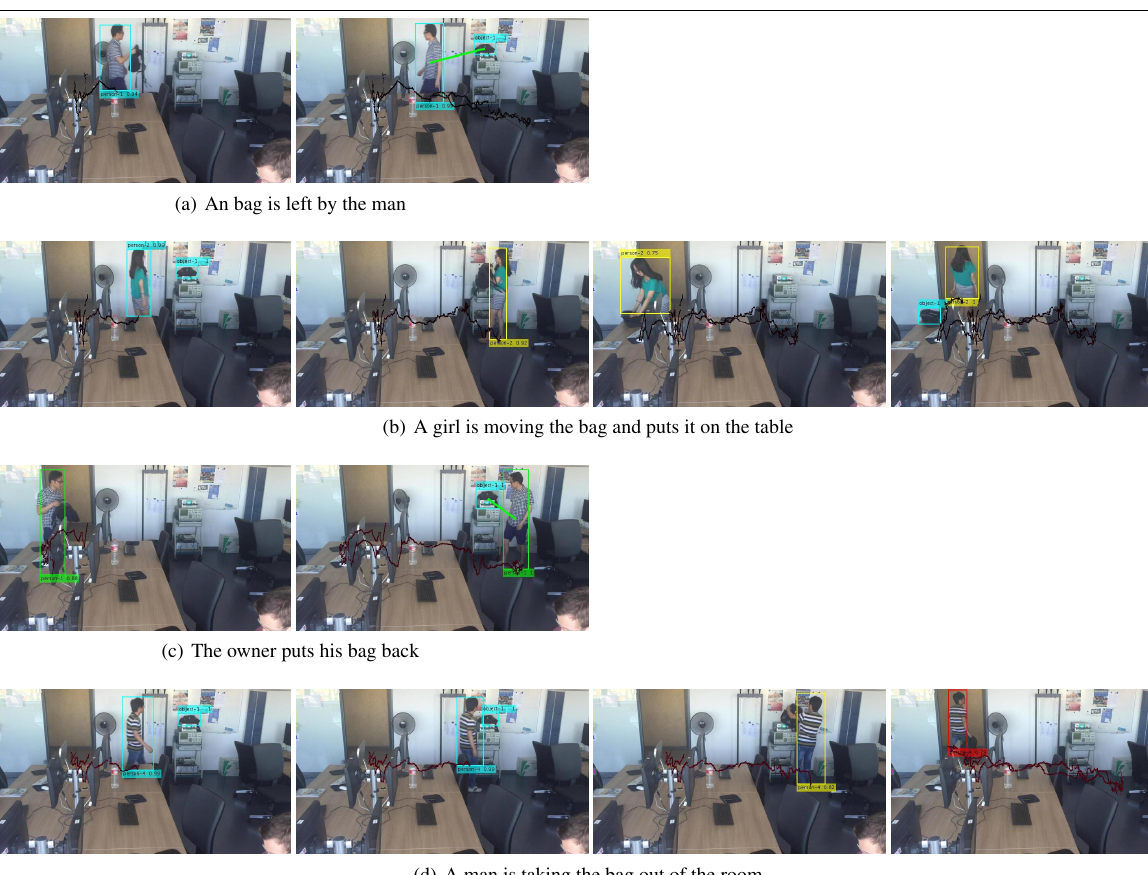
Figure 6: An example of typical experimental results on SERD. In this scene, series of events happens around a bag. The green bounding box means that the man is the owner and he is allowed to move the bag. (a) A bag is left in the room and the man is labeled as its owner (indicates with the green connecting line). (b) A girl comes to move the bag to a table. Her activity is alarm in yellow, because she is not the bag’s owner but the bag is still within surveillance region. (c) The owner comes back to move his bag to another place. He is indicated in green because he is verified as the bag’s owner. (d) Another man comes to take the bag away. A yellow alarm is caused when he is taking the bag but still in the room. Then the alarm turn in red when he goes out the room. bag up and walks out of the scene. Our method does not proceed the semantic analysis of familiar/known person to the